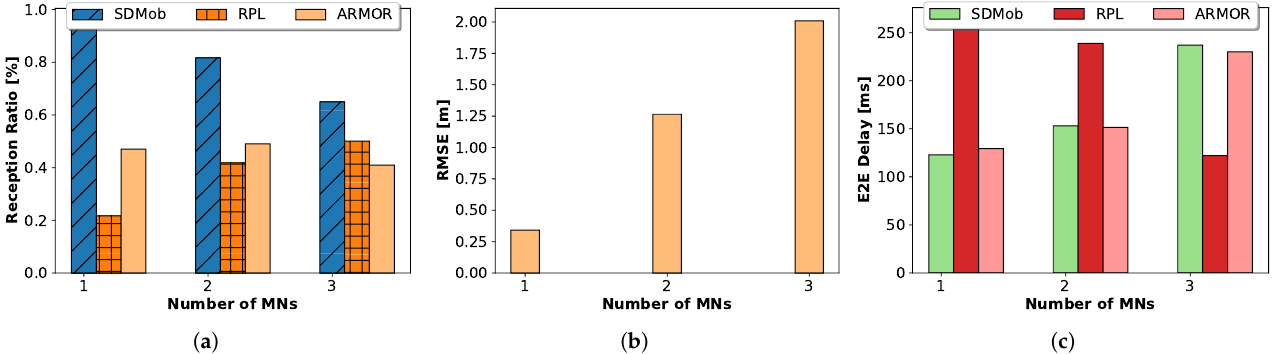
Figure 10. Simulation results for increasing number of MNs with different solutions—( a ) PDR; ( b ) localiza- tion error; and ( c ) end-to-end delay.